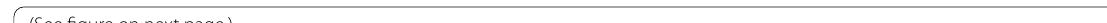
figure on next Fig. 3 A Scatterplot and linear regression of the relationship between ratio of perfusions and peak enhancement ratios. Three points for each patient are included: empty squares for kidney/pancreas data, empty triangles for kidney/hepatocellular carcinoma (HCC) data, and black upside-down triangles for pancreas/HCC data. Regression equation: enhancement ratio = 0.75 + 0.39 × ( perfusion ratio ) , r 2 Perfusion data refer to the perfusions computed as maximal upslope of the time-enhancement curve obtained using all data points smoothed with the spline function. B Bland–Altman plot for the comparison between enhancement and perfusion ratios, showing a -0.68 bias (red line), with green lines indicating the lower (-2.34) and upper (1.01) limit of